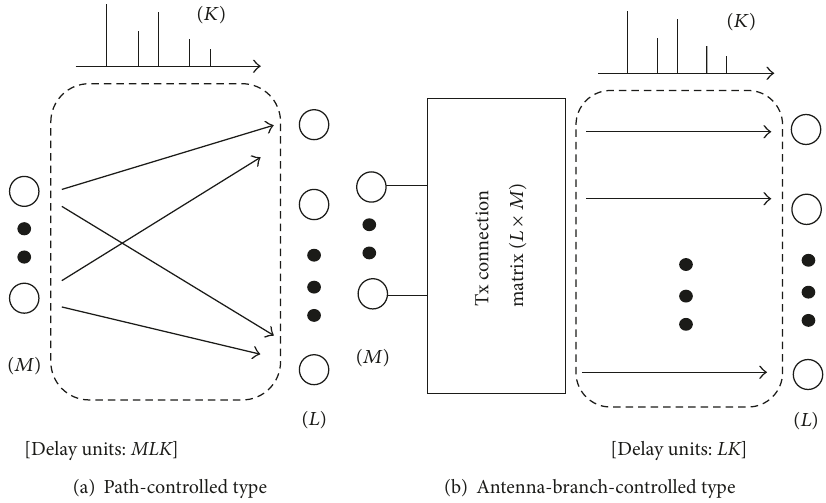
Figure 3: Configurations for delay